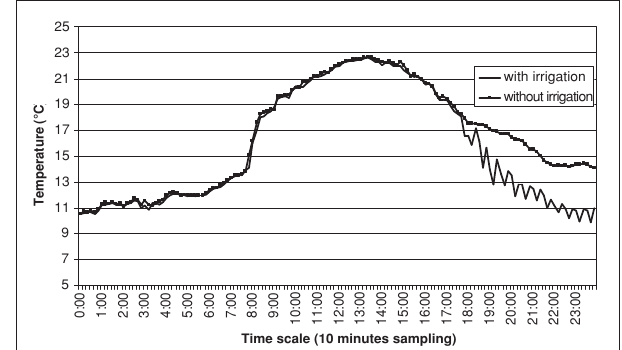
Figure 4. The effect of night time irrigation on the temperature of the apple plantation on the day when the air humidity was below 75% 2nd of May,